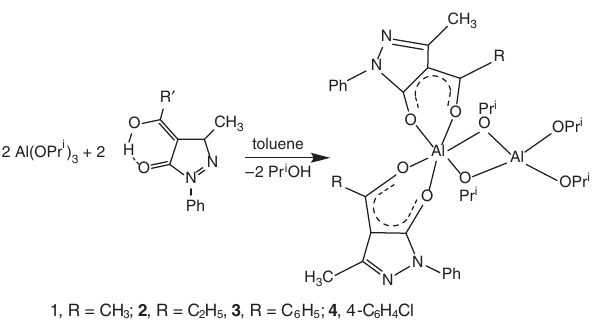
Scheme 1: Synthesis of asymmetric dinuclear aluminium compounds ( 1 − 4